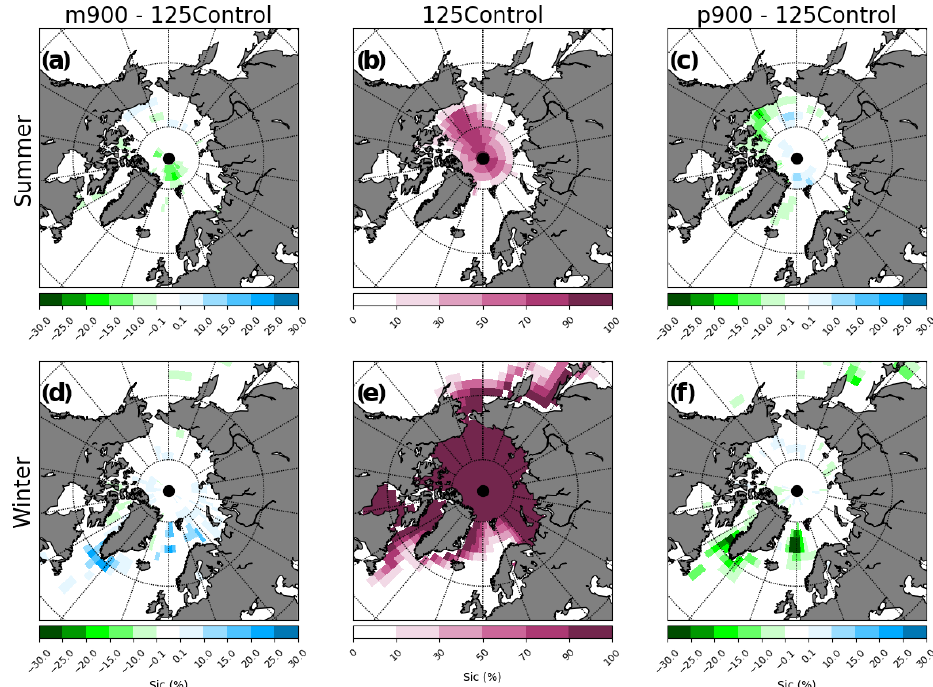
Figure 5. Sea ice concentration anomalies (%) for summer (September) and winter (March) for scenarios m900 (a, d) and p900 (c, f) compared to the 125Control simulation. Also shown is absolute sea ice concentration for the 125Control simulation for summer (b) and winter (e) . Only the anomalies statistically significant at the 95% confidence level are